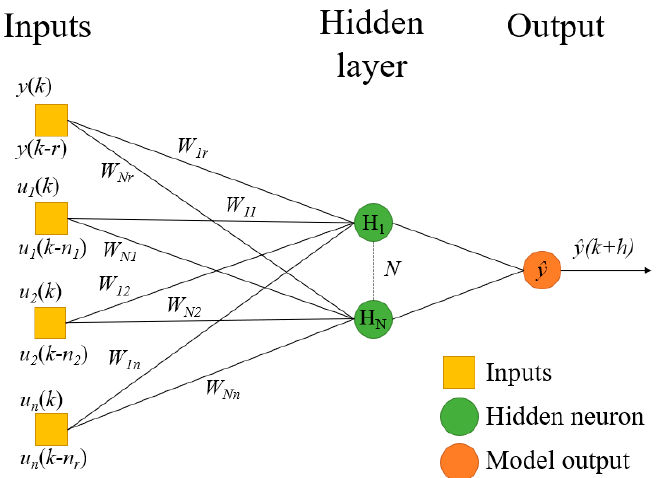
Figure 1. Multilayer Perceptron representation, with x i , the exogenous variables; W , the matrix of parameters; y , the measured output; ŷ , the predicted output; r , the order of the model, n r , the input window width; H i ( i = 1 to N ) the hidden neurons; N , the number of hidden neurons; k , the discrete time and h , the lead time [13].